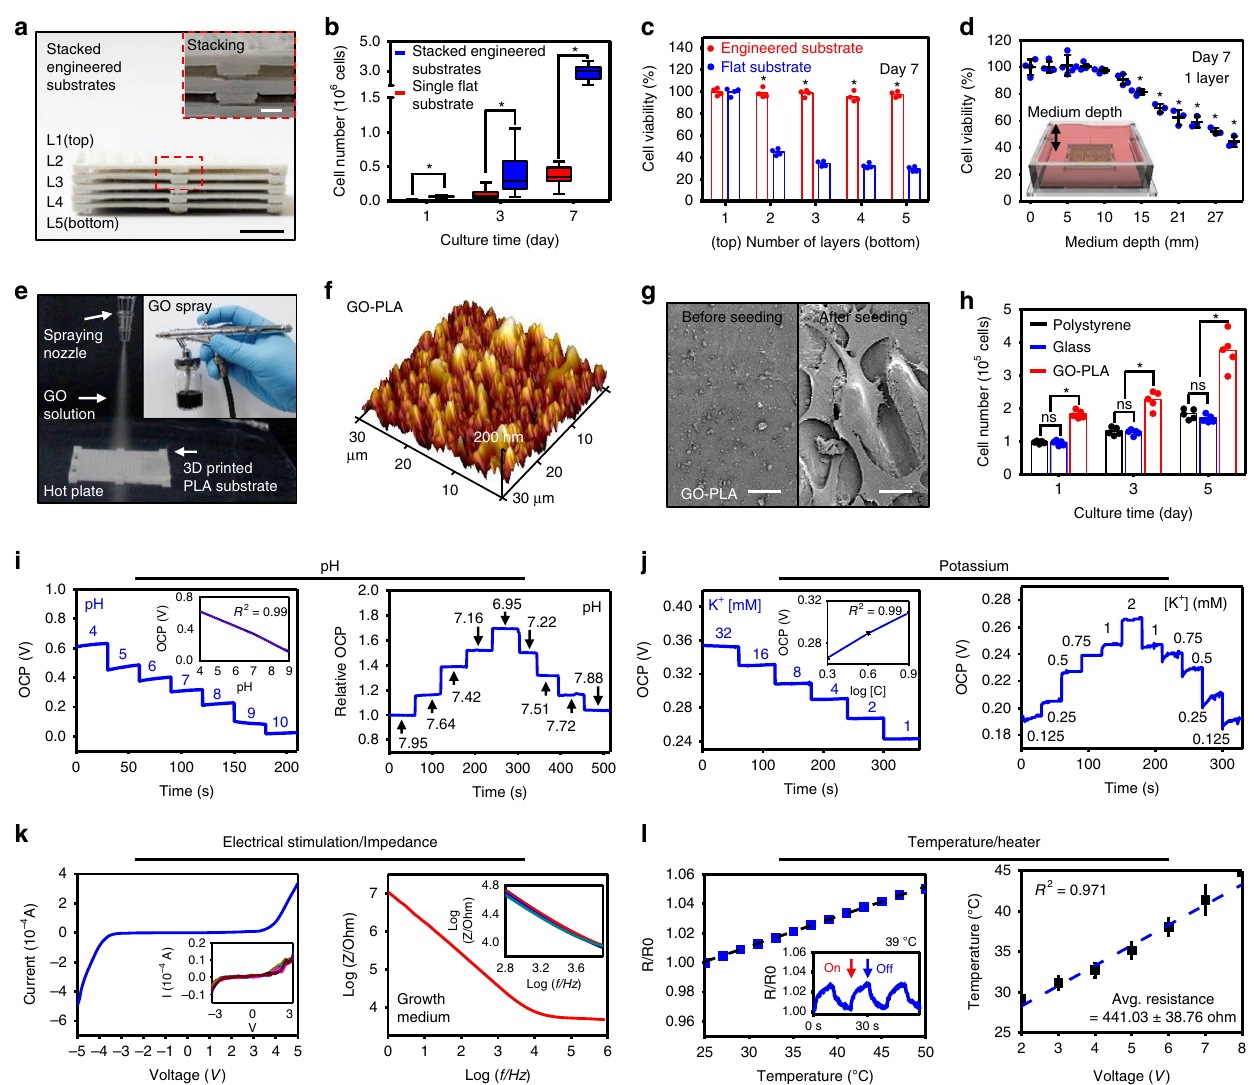
Fig. 2 Characterization of cell culture substrate and ultrathin sensors and actuators. a Photograph of stacked 3D-printed engineered substrates (side view, scale bar: 1 cm) and magni fi ed view of the assembly region (inset, scale bar: 2 mm). b Plot comparing cell attachment on a stack of engineered substrates and on a single fl at substrate. ( n = 5, Box: median; 25th to 75th percentiles, Whisker: min to max, * P < 0.001 with two tailed unpaired t test). c Plot showing cell viability in each layer of the fi ve-layer stack of engineered substrates and fl at substrates. The number of the layers descends from the top layer. ( n = 4, mean, * P < 0.001 versus fl at substrate, ANOVA with Bonferroni ’ s post-test). d Plot showing the viability of cells based on the depth of culture medium ( n = 3, mean ± s.d., * P < 0.001 compared to control (depth = 0 mm), ANOVA). e Image showing GO spray-coating onto the 3D printed PLA substrate. Inset shows a spray containing GO. f AFM image of the GO-coated PLA substrate. g SEM images of the GO-PLA substrate before and after cell seeding. Scale bar: 20 μ m. h Plot showing the number of cells cultured on polystyrene, glass, and GO-coated PLA substrates ( n = 4, mean, * P < 0.001, ANOVA with Bonferroni ’ s post-test, ns, not signi fi cant). i – l Characterization of sensors and stimulators. i The graphs show the open-circuit potential (OCP) measurements from pH sensor at the pH range of 4 – 10 (left) and in subtle changes between pH 6.95 and 7.95 compared to a commercial pH sensor (numbers on each step) (right). j The graphs show OCP measurements from K + sensor at concentrations between 1 and 32 mM (numbers on each step) (left) and in subtle changes between 0.125 and 2 mM (right). The insets in i , j show calibration curves for both ion sensors ( n = 5). k Current – voltage plot of electrical stimulator (left) and log – log plot of the impedance measurements at different frequencies (right). Insets show reproducibility ( n = 16 for left and n = 4 for right). l Graphs showing the resistance of temperature sensor changes with temperature (left) and thermal stimulator response to sudden temperature variations (inset). Graph showing the relationship between heat and applied voltage ( n = 16)